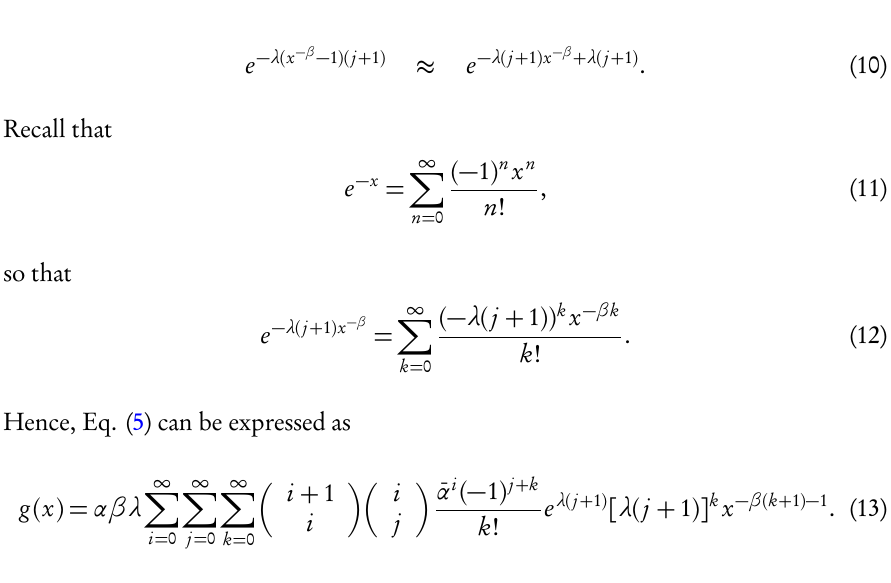
decreasing, increasing, and right-skewed unimodal shapes for different choices of the parameters of the